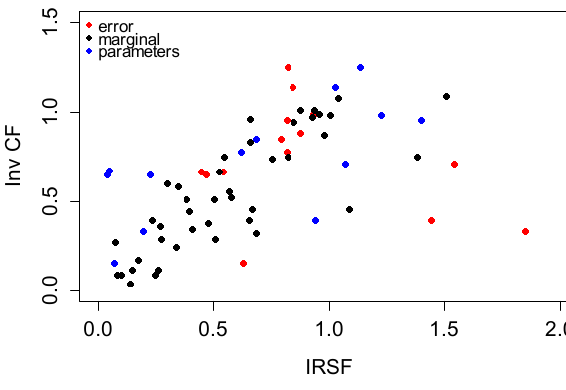
Figure 2. ICF vs IRSF.